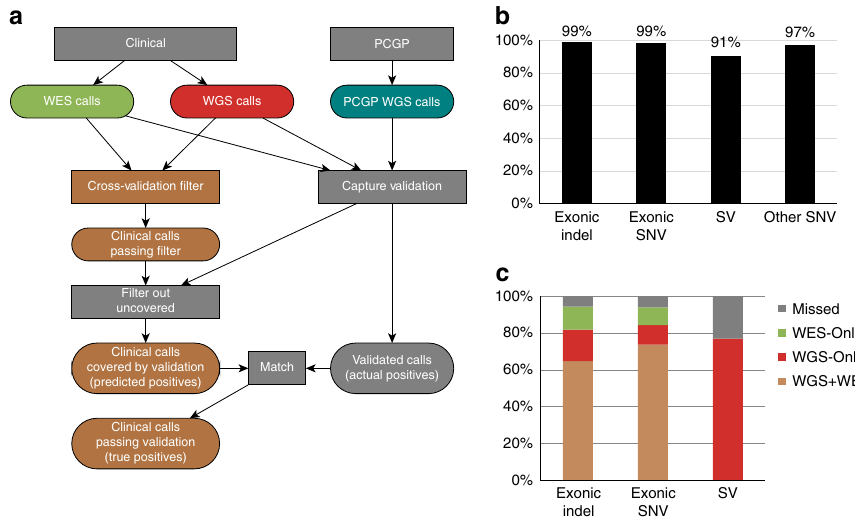
Fig. 3 Accuracy of somatic variant detection based on capture validation of 18 cases with PCGP data. a Design of capture validation for measuring sensitivity and PPV of our analytical pipeline using somatic exonic SNV/indel detection as an example. For exonic SNV/indel, variants that passed the cross-validation fi lter and had adequate coverage from custom capture sequencing were considered “ predicted positives ” . Predicted positives that were validated by capture sequencing are considered true positives whereas all variants — including those that failed to be detected or those fi ltered by cross- validation fi ltering — that were validated by capture sequencing are considered “ actual positives ” . b Summary of PPV (true positives/predicted positives) for each variant type. The predicted positive variants for exonic indels and SNVs are the variants that pass the cross-validation fi lter, whereas other SNVs, which refers to high-con fi dence non-exonic SNVs, are based on WGS only; as such, they are reported separately. Our test does not report non-exonic indels, so they are omitted. c Summary of sensitivity (true positives/actual positives) for each variant type. For exonic SNV/indel, most of the variants are detected by our variant detection pipeline on both WGS and WES (WGS + WES) platforms; of those that are detected by our pipeline on one platform, results for WGS and WES were comparable, with slightly more detected by WGS. The “ Missed ” variants are the false negatives; they were removed by cross-validation fi ltering or only detected by